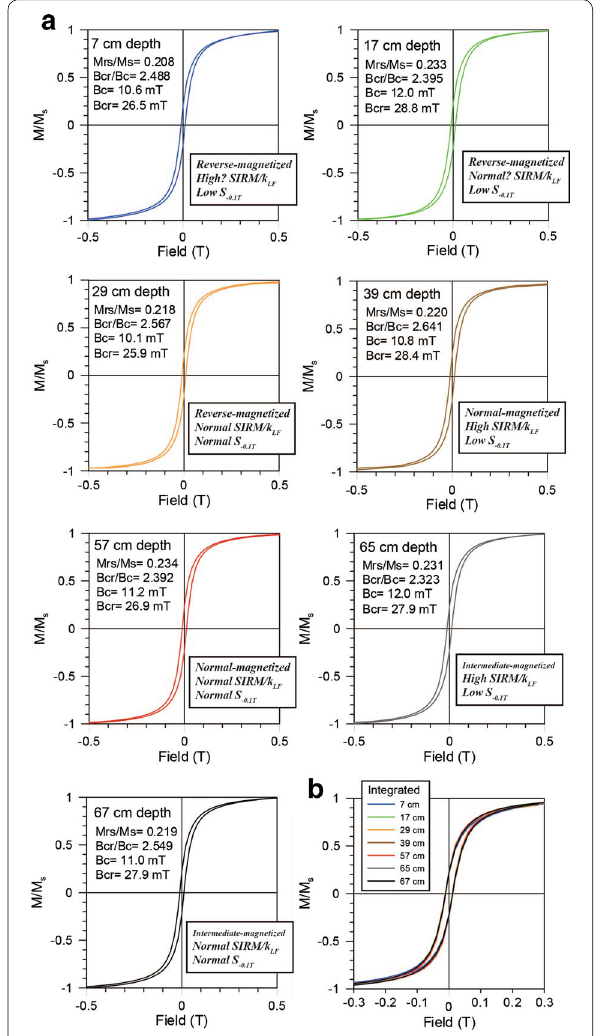
Fig. 9 a Magnetic hysteresis loops after correcting for the paramag‑ netic contribution at randomly selected different horizons (from 7 to 67 cm depth) of the GSDS1 profile, and b their integrated plots showing little or no differences between the loops